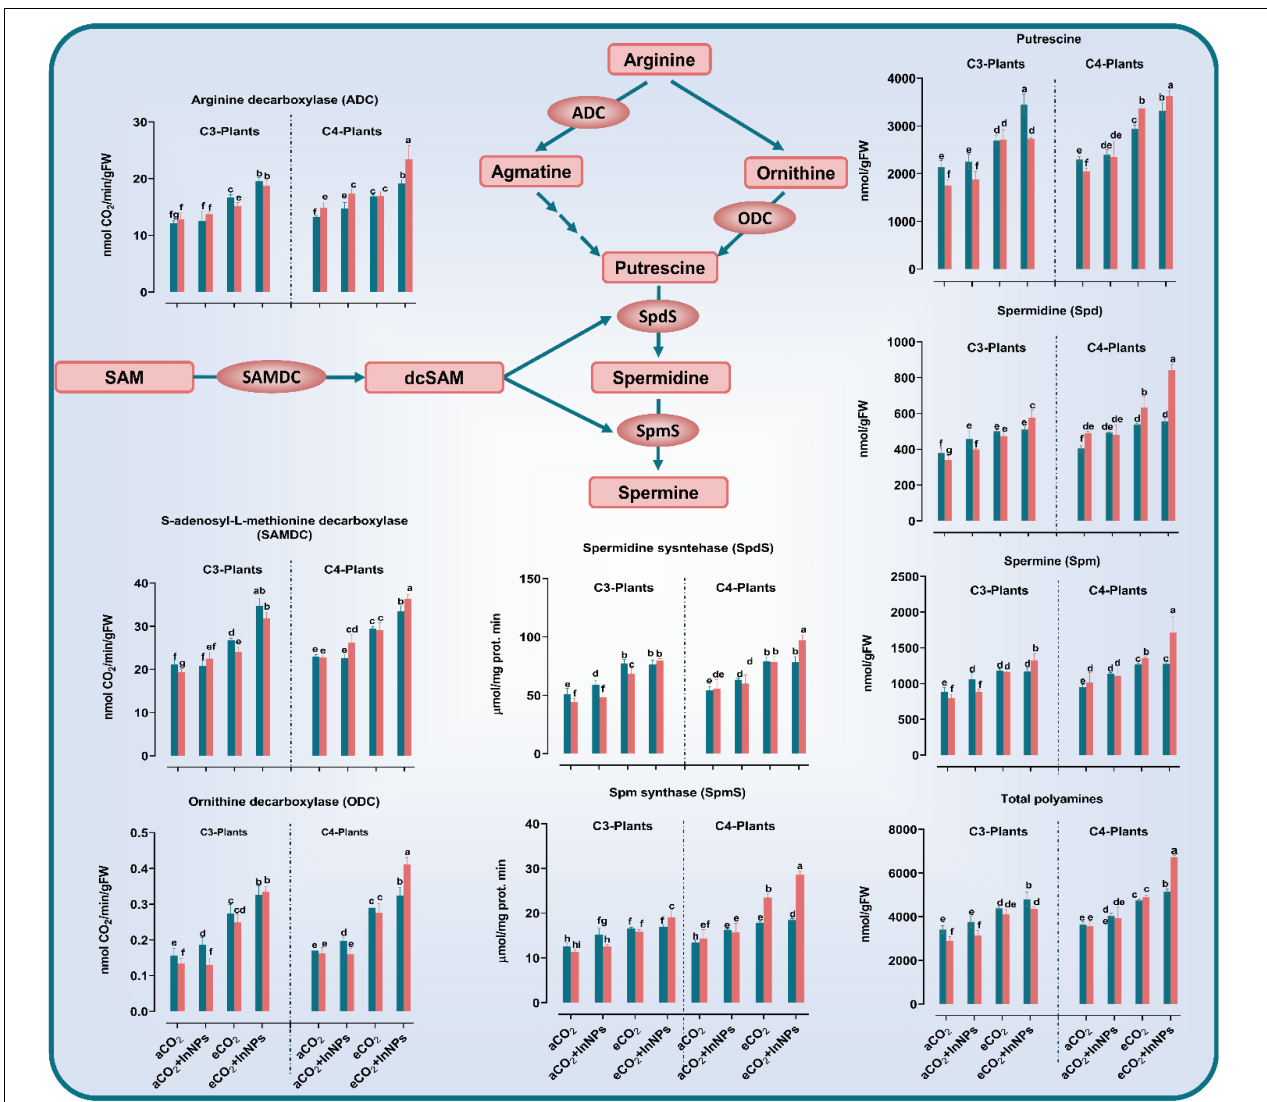
FIGURE 5 | Effect of the co-application of future climate CO 2 and In 2 O 3 -NPs upon polyamine metabolism in both old and young leaves of C3 and C4 plants. Four biological replicates are used to measure each value. The bars on the columns represent error bars (SE). One way ANOVA test ( P < 0.05; n = 4) was applied to show the significant difference between groups. Different letters showed the significant difference between